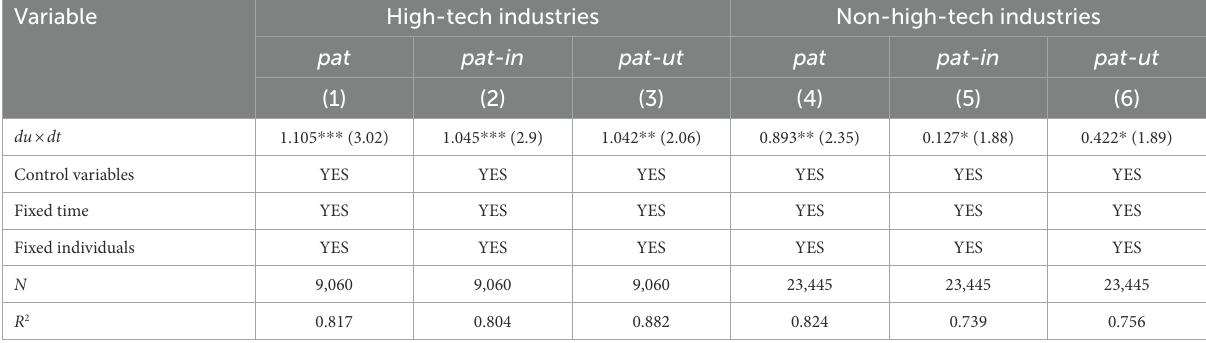
TABLE 6 Heterogeneity test results of different industries.